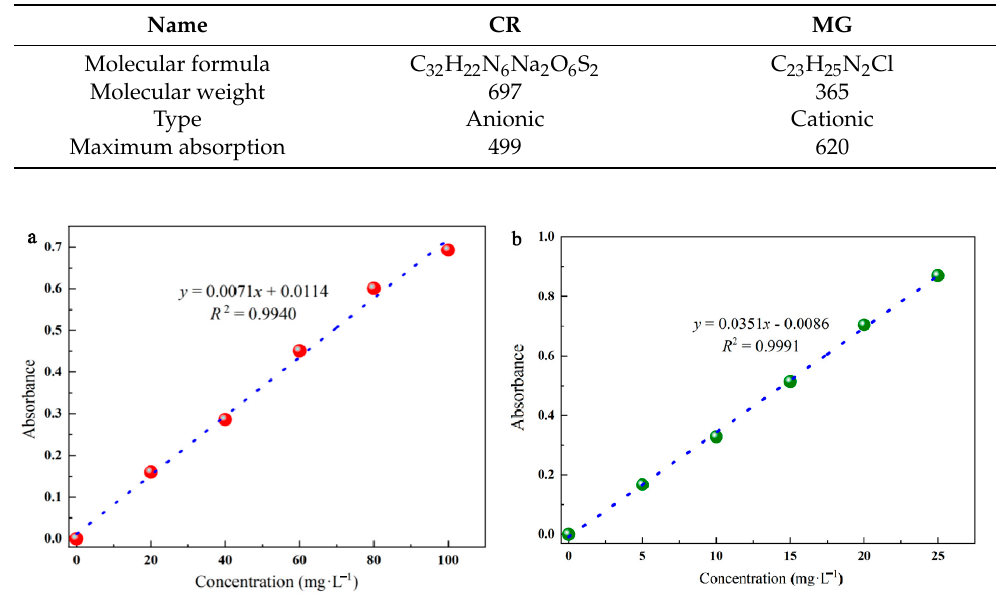
Figure 9. Equation of the fitted standard curve, CR ( a ) MG ( b ).